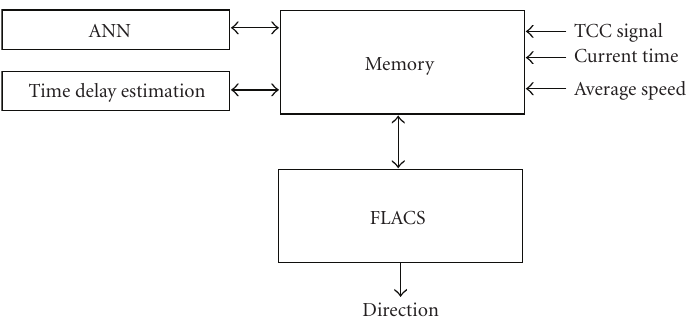
Figure 4: Block diagram of the proposed FLACS route selection system.